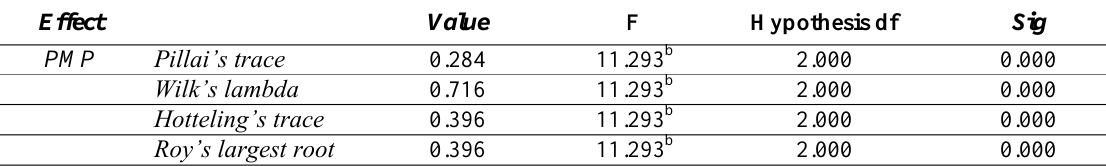
Table 5: Results of analysis between intervention and control group (n=60)